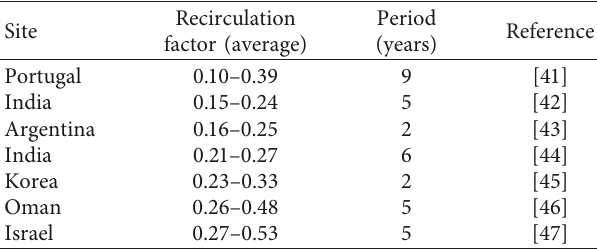
Table 4: Recirculation factor calculated in different